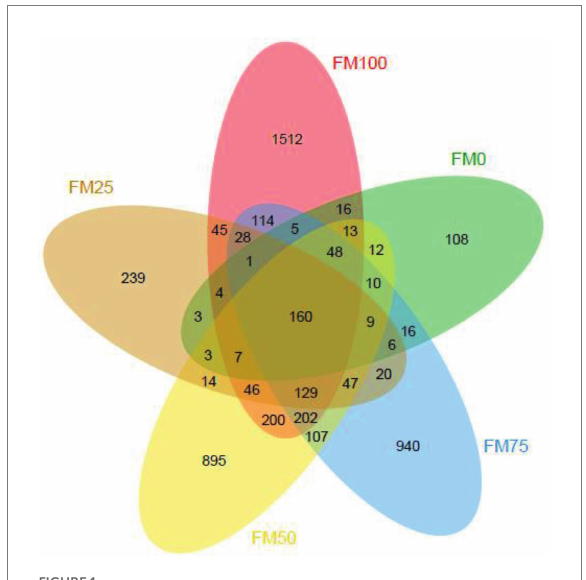
FIGURE 1 Venn diagram showing the observed ASVs of gut microbial communities from the five different levels of fishmeal replacement groups of largemouth bass. FM100 represents the fishmeal diet without Chlorella meal; FM75, FM50, FM25, and FM0 represent the fishmeal diet with 25, 50, 75, and 100% fishmeal replacement by Chlorella meal, respectively.